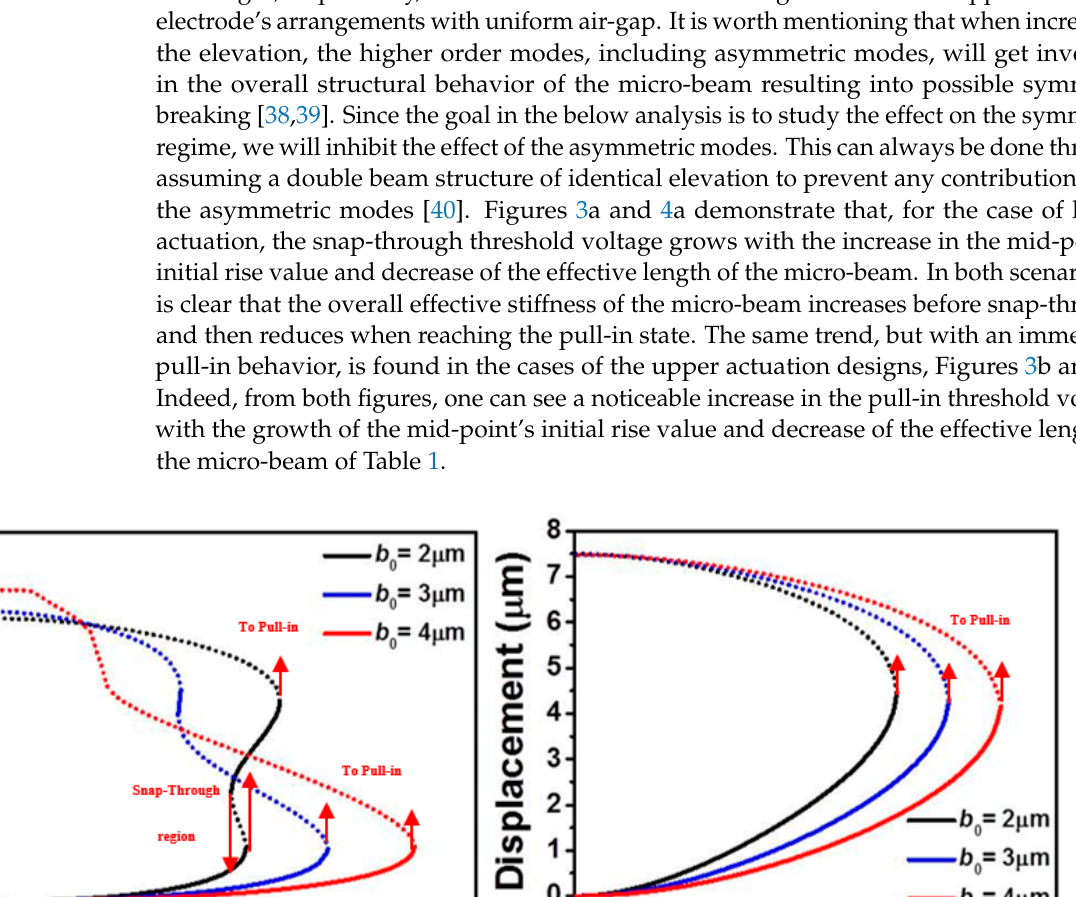
Figure 4. The static displacement with a uniform g and for various values of length ( L ) under V DC for ( a ) Case 1 and ( b ) Case 2 (solid: stable, dashed: unstable). 5. Eigenvalue Problem Analysis In order to further investigate the various designs, we examine next the variation of the eigenvalues (in-plane flexure natural frequencies) of the micro-beam with the DC load. Figures 5 and 6 show the effect of the DC load and both gap-size configurations (uniform and non-uniform cases) on the variation of the four lowest natural frequencies of the CO- SINE-shaped micro-beam for both cases of upper and lower electrostatic actuation, re- spectively. In both cases of uniform and non-uniform air-gap size, the first four in-plane flexure natural frequencies are all displaying a constant decrease until reaching the snap- through instability where the fundamental (lowest) frequency, Figure 5a, drops instanta- neously to zero. For this configuration, this behavior proves the dominance of the quad- ratic nonlinearity, tending to soften the micro-structure, arising from both the initial cur- vature and the actuating force. For the case of the non-uniform air-gap size, since the mi- cro-beam still has enough room to snap and then reaches its second snap state, its